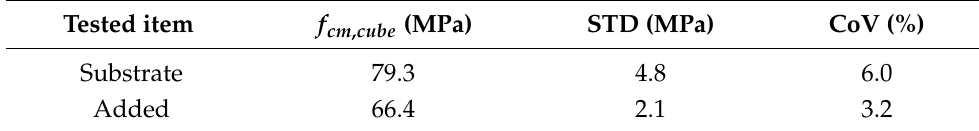
Table 5. The main laboratory tests’ outcomes for the used concretes in reference [25].